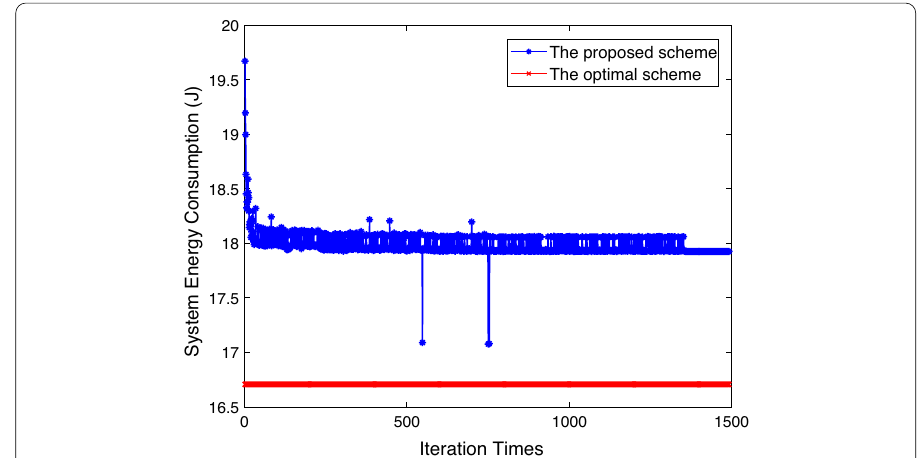
Fig. 6 The energy consumption comparison between the proposed scheme and the optimal scheme versus iteration times (notably, the iteration times here refers to the serial number of the second layer of loop in Algorithm 1)